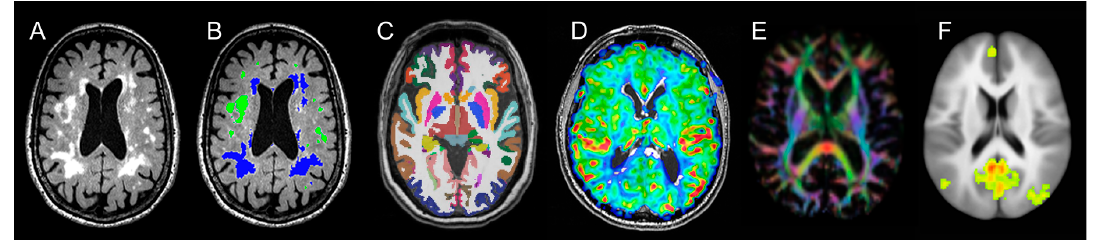
Figure 2. Neuroimaging endpoints available in the PUFA Trial. ( A ). Fluid-attenuated inversion recovery (FLAIR) sequence illustrating prominent total WMH; ( B ). WMH segmentation classified into deep (green) and periventricular (blue); ( C ). T1 grey matter segmentation including medial temporal lobe (brown); ( D ). 2D Pseudo-Continuous Arterial Spin Labeling (pCASL) sequence for cerebral blood flow; ( E ). Diffusion Tensor Imaging (DTI) derived fractional anisotropy direction color-coded; ( F ). fMRI derived default mode network activity at resting